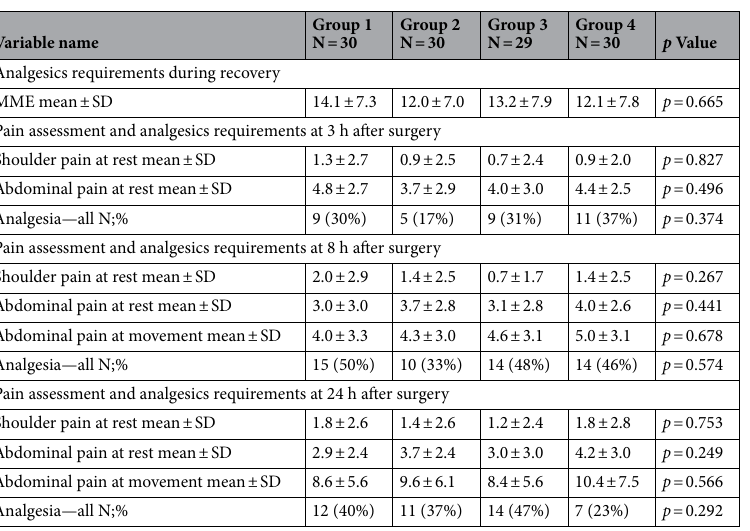
Table 4. Univariate comparison of post-operative pain assessment and analgesic requirements according to study groups. *Comparisons of longitudinal data (MME, VAS scores) were performed using One Way Analysis of variance (ANOVA). Comparison of Dichotomous variables (Analgesic treatment and treatment with opiates at 3, 8 and 24 h post surgery) were performed using the Chi-square or Fisher exact test. **MME—Morphine Milligram Equivalents; VAS—visual analog